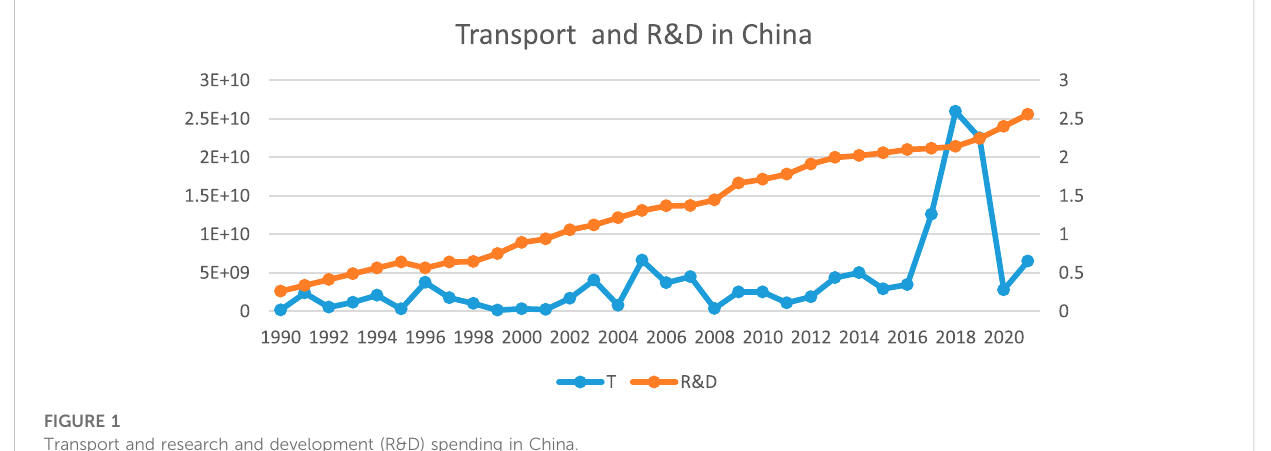
FIGURE 1 Transport and research and development (R&D) spending in